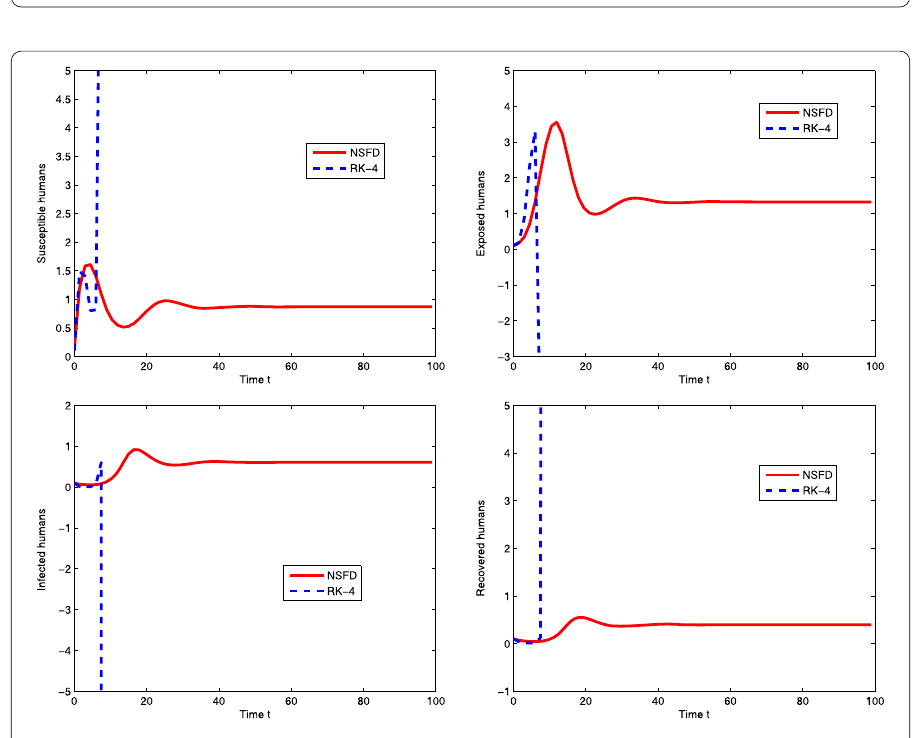
Figure 5 Comparison of solutions obtained by NSFD and RK4 numerical schemes for F 1 with an initial condition ( S (0), E (0), I (0), R (0)) = (0.1,0.1,0.1,0.1) and step size h = 1.5 with R 0 = 7.0735 > 1. The comparison shows that the RK4 scheme fails to converge. However, the NSFD scheme improves the result obtained by RK4 and it is seen to be convergent dynamically to the correct endemic equilibrium F